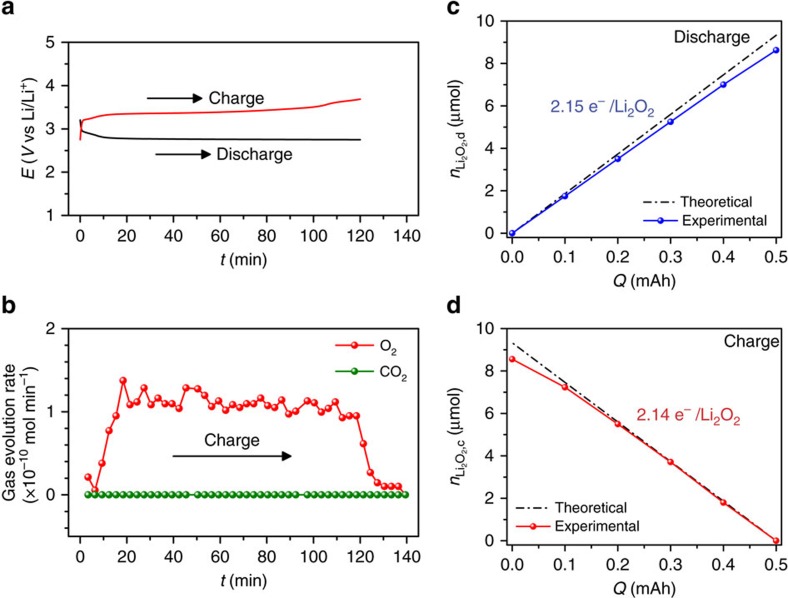
Reversibility during discharge and charge processes in the G4-UH2O2 electrolyte.(a) Discharge and charge profiles of a Li-O2 cell with G4-UH2O2 electrolyte during the in situ DEMS measurement. (b) Corresponding O2 and CO2 evolution rates during charge. (c) The quantified level of Li2O2 formation, nLi2O2,d, during discharge determined by titration. (d) The quantified level of Li2O2 consumption, nLi2O2,c, during charge determined by titration.